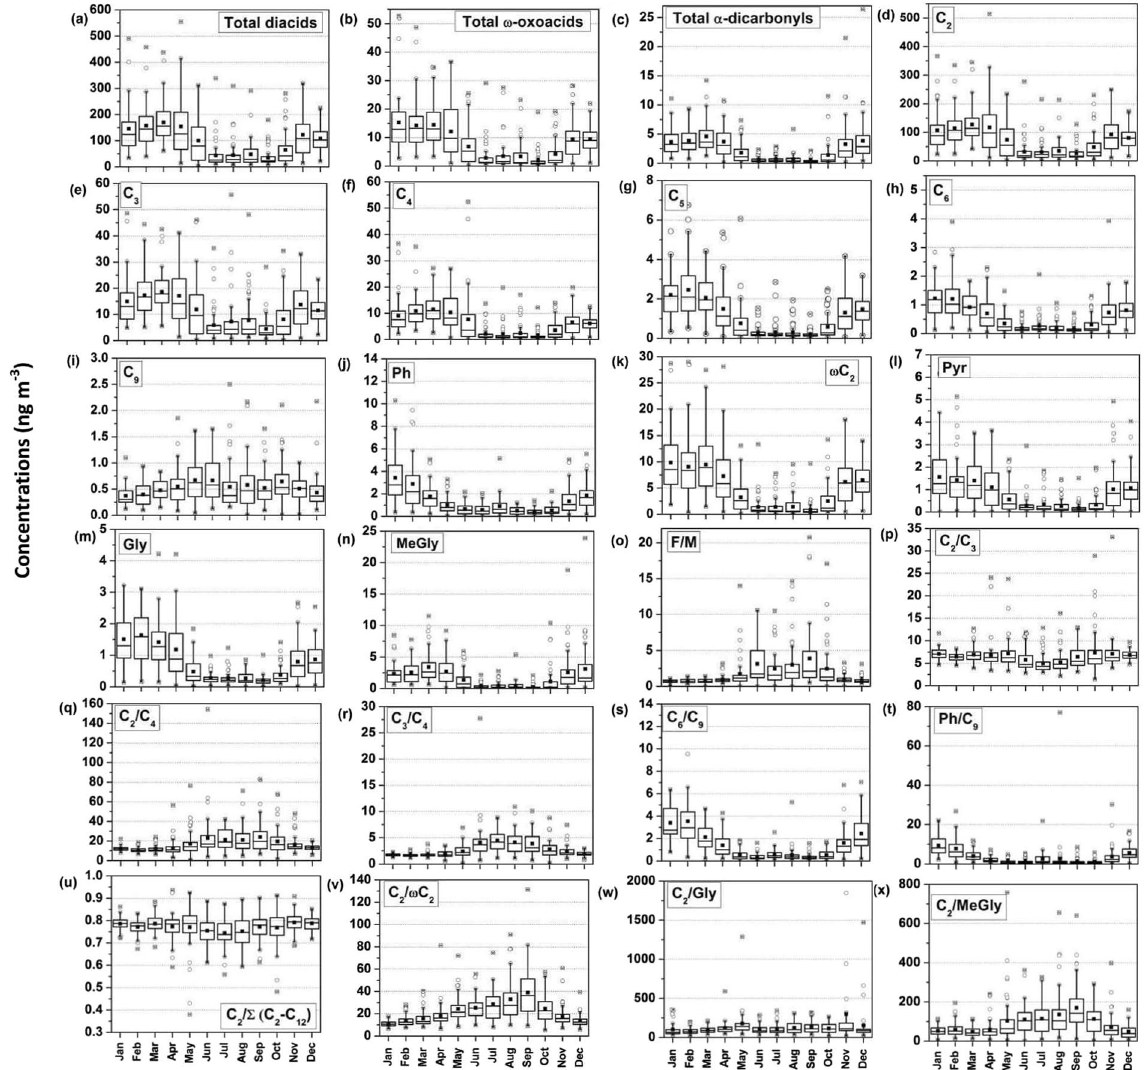
Figure 3. Monthly variations in water-soluble dicarboxylic acids (ng m − 3 ) and related compounds (ng m − 3 ) and various mass ratios at Chichijima during 2001 to 2013. The horizontal line and dot inside the box indicate maiden and mean, respectively. The vertical hinges represent data points from the lower to the upper quartile (i.e., 25 th and 75 th percentiles). The whiskers represent data points from the 5 th to 95 th percentiles. Open circles indicate the